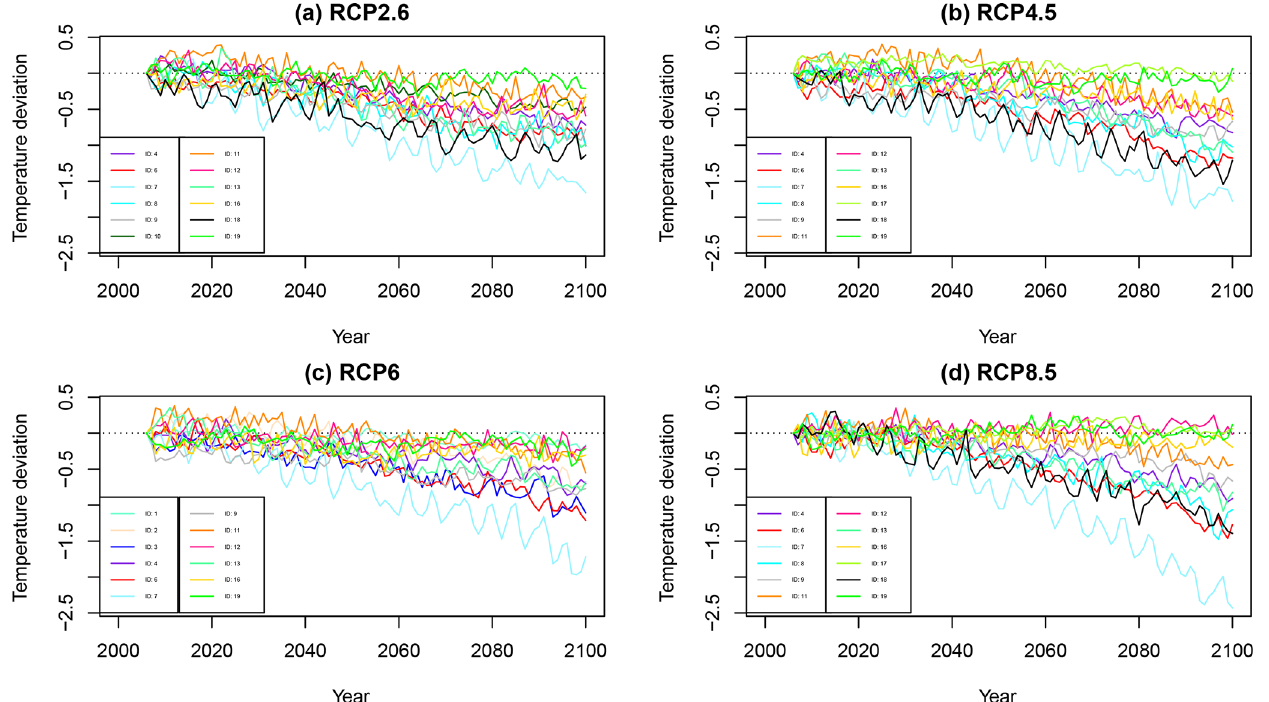
Figure 7. Panels (a) – (d) describe the deviations between the predicted marginal posterior means and the predictions obtained from each